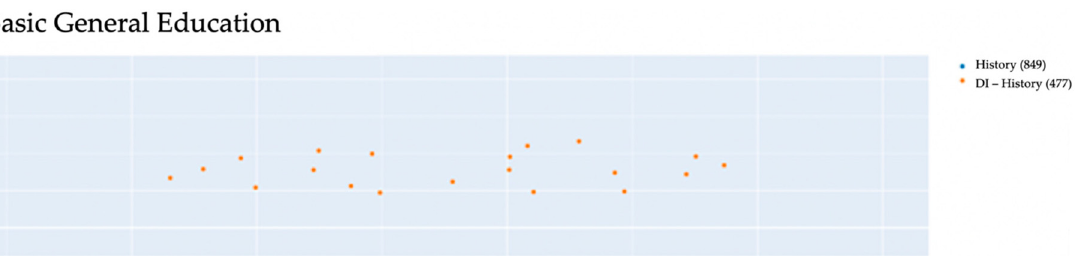
Figure 11. Semantic cluster including different historic